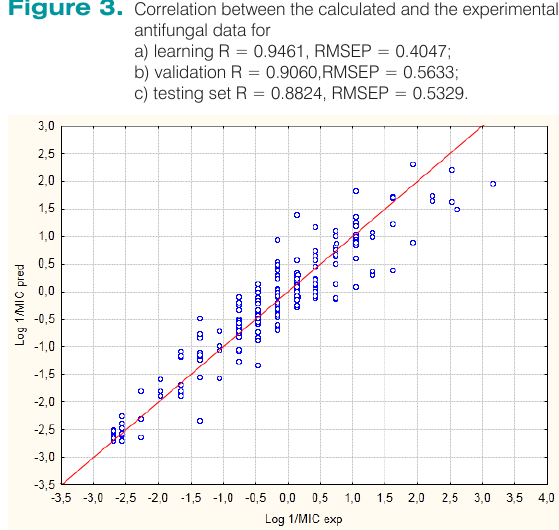
Figure 2. Learning curve of MLP: 38:8:1. Figure 3. Correlation between the calculated and the experimental